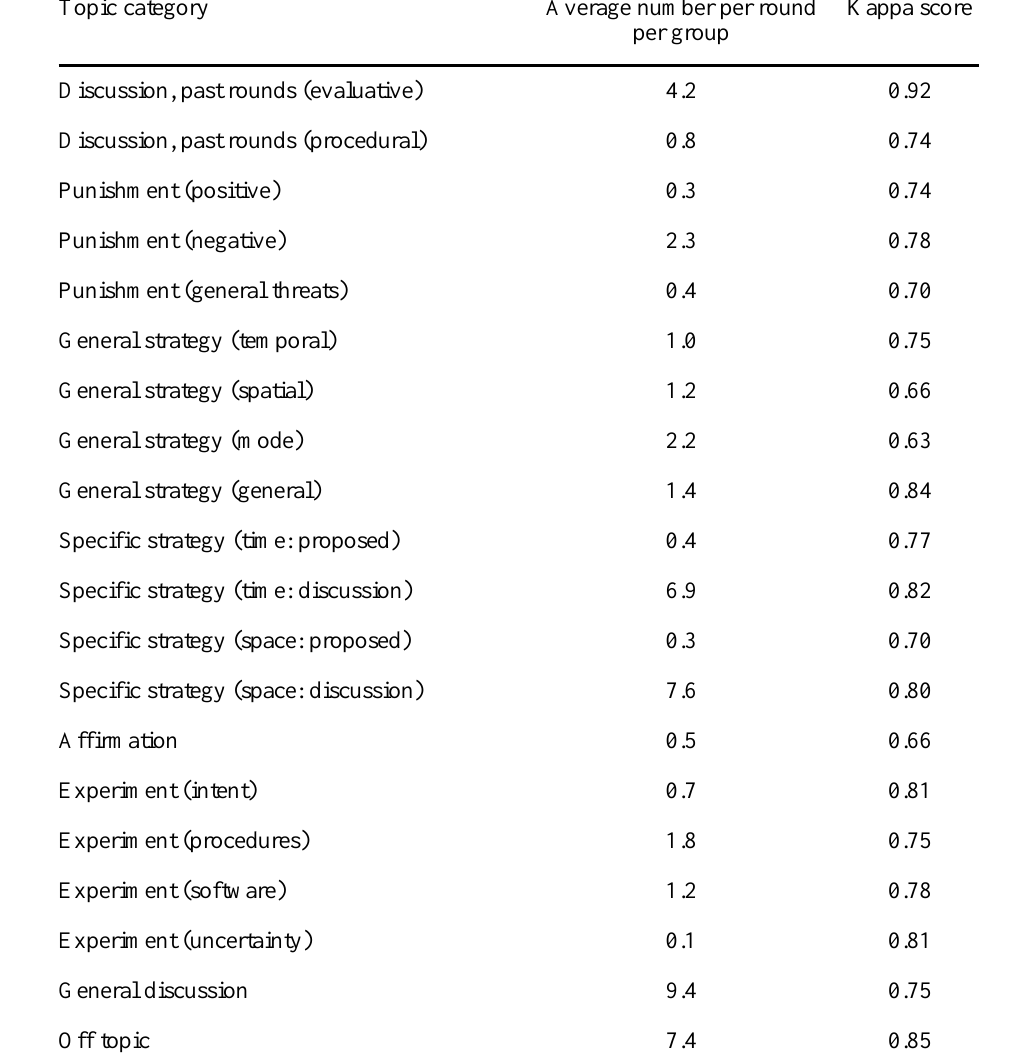
Table 3. The average number of lines of text messages for the different categories distinguished. The agreement of the two coders is quantified by the kappa score. A kappa score above 0.8 suggests very good agreement, and a kappa score between 0.6 and 0.8 suggests good